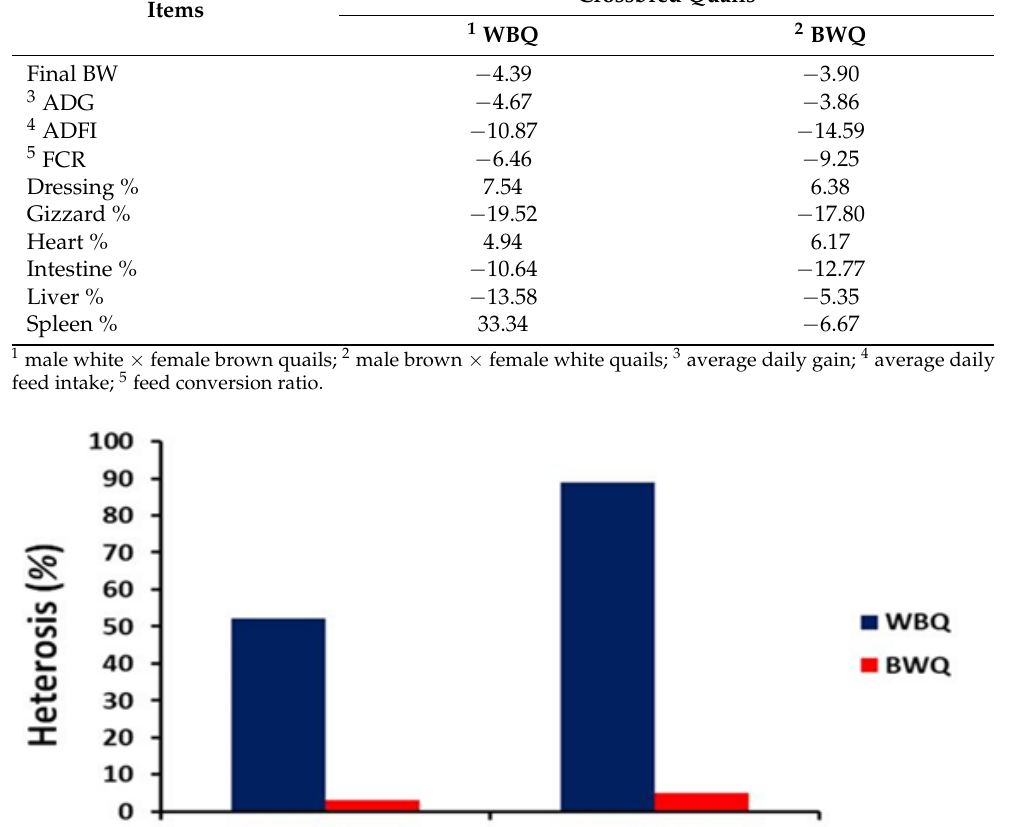
Table 6. Heterosis percentages of growth performance and carcass traits for crossbred quail lines. Items